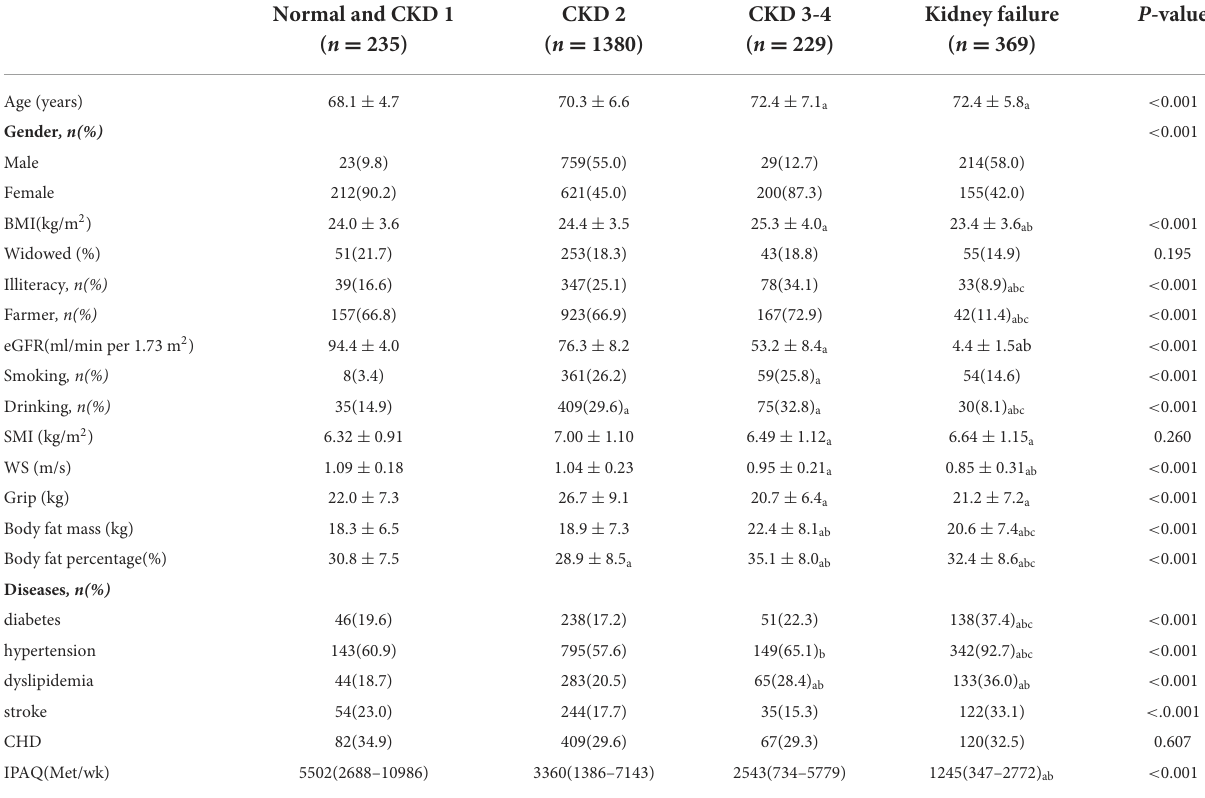
TABLE 1 Baseline data classified by CKD